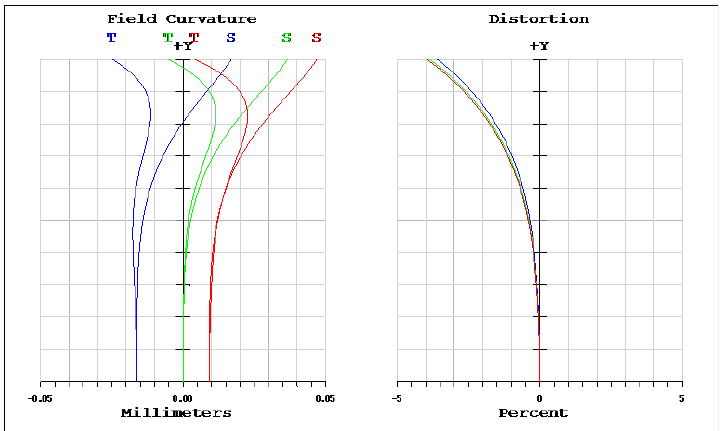
Figure 5. Field curvature ( left ) and distortion plot ( right ) of a miniaturized wide-angle fisheye lens using an OKP4HT aspherical lens.